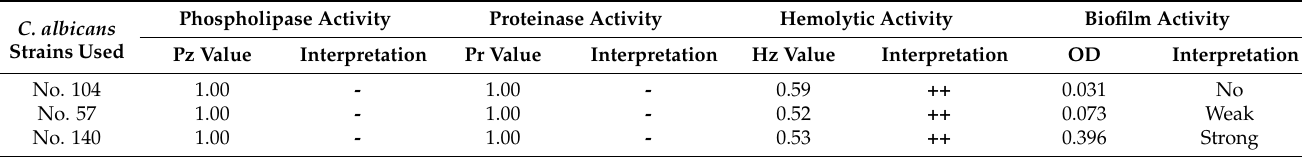
Table 2. Determination of in vitro virulence factors.